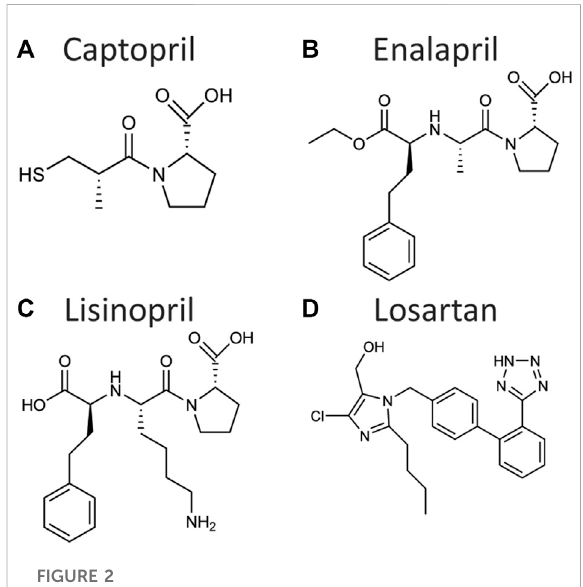
FIGURE 2 Chemical structure of the angiotensin-converting enzyme inhibitors Captopril (A) , Enalapril (B) , and Lisinopril (C) , and of the angiotensin II receptor blocker Losartan (D) . These drugs have been shown to control aging in C. elegans , Drosophila , and/ or